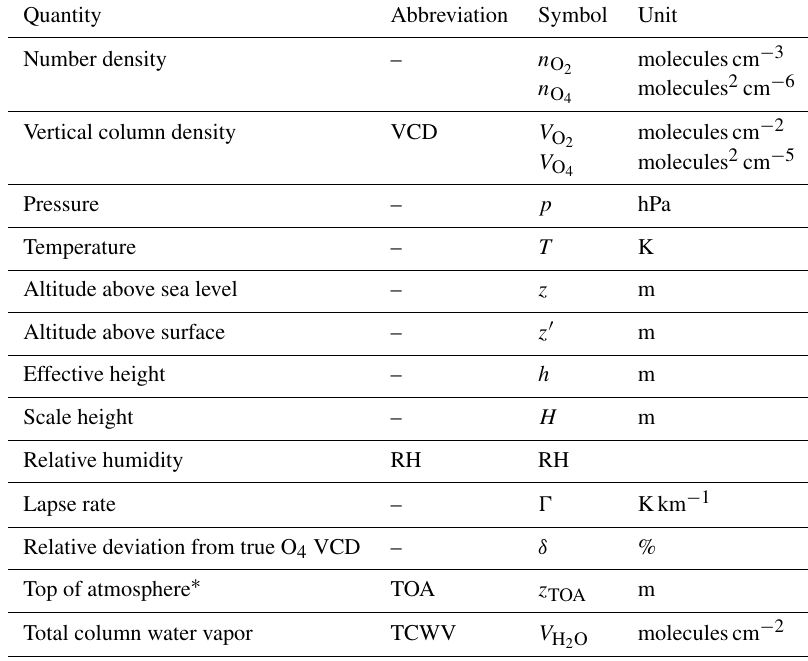
Table 1. Variables used in this study. A subscript of 0 indicates surface values for n , p , T , z , or RH. Quantity